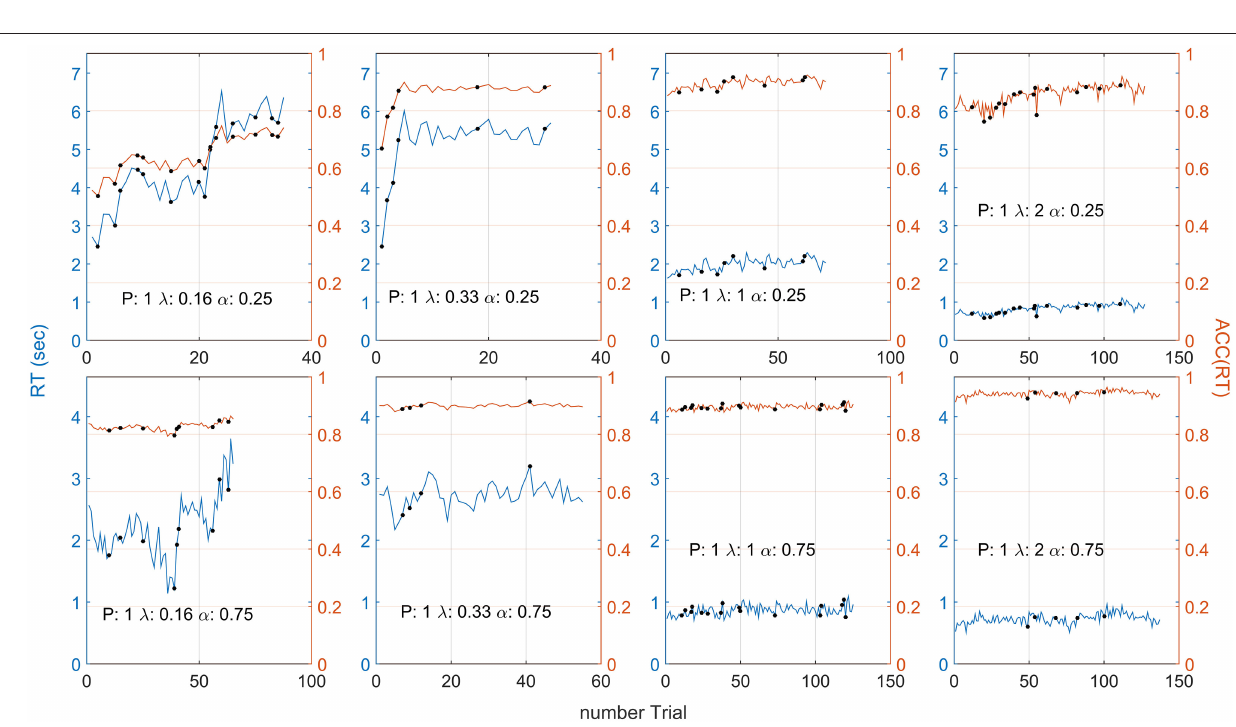
0.25 condition. Note that the different number of trials = 0.25 , λ 0.16 , the gauge grew more slowly, participant’s RT were slower, and = =